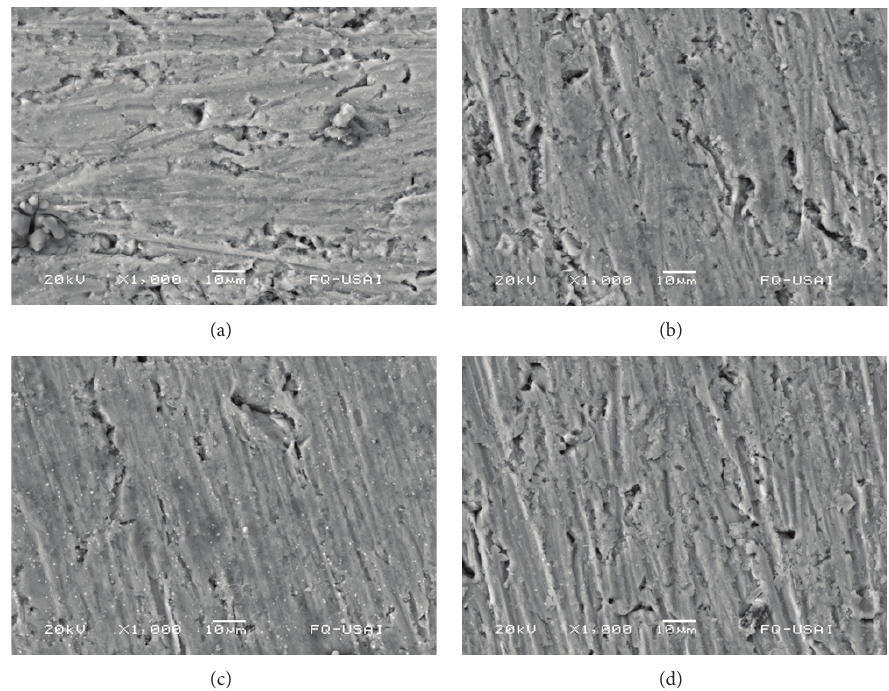
Figure 1: SEM images of aluminum conversion layers in cerium bath (0.1g L −1 ) at different concentrations of accelerator (boric acid); (a) 0,